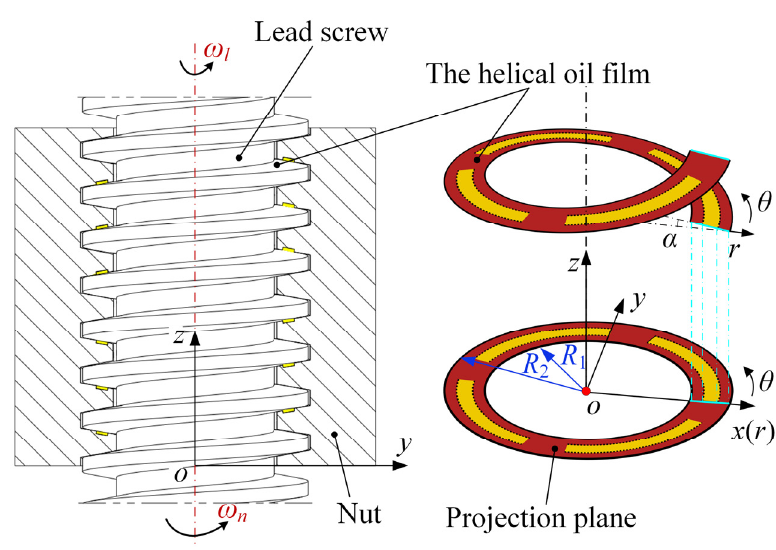
Figure 3. Oil film diagram of the hydrostatic lead screw.